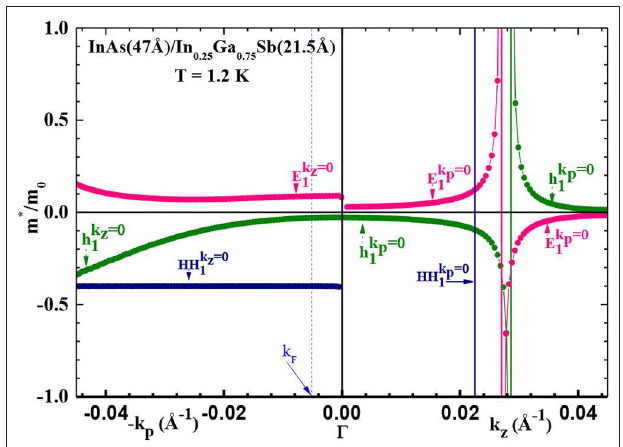
FIGURE 6 | Calculated carrier’s effective mass along the growth direction and in plan of the investigated